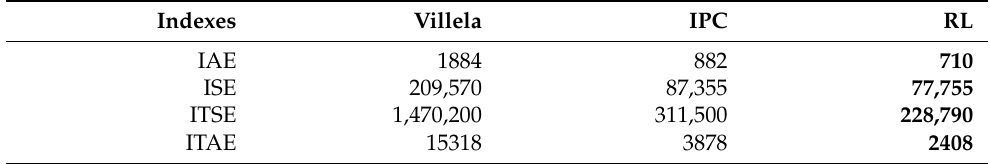
Table 2. Performance indexes X p = − 80 cm, Y p = 0 cm.